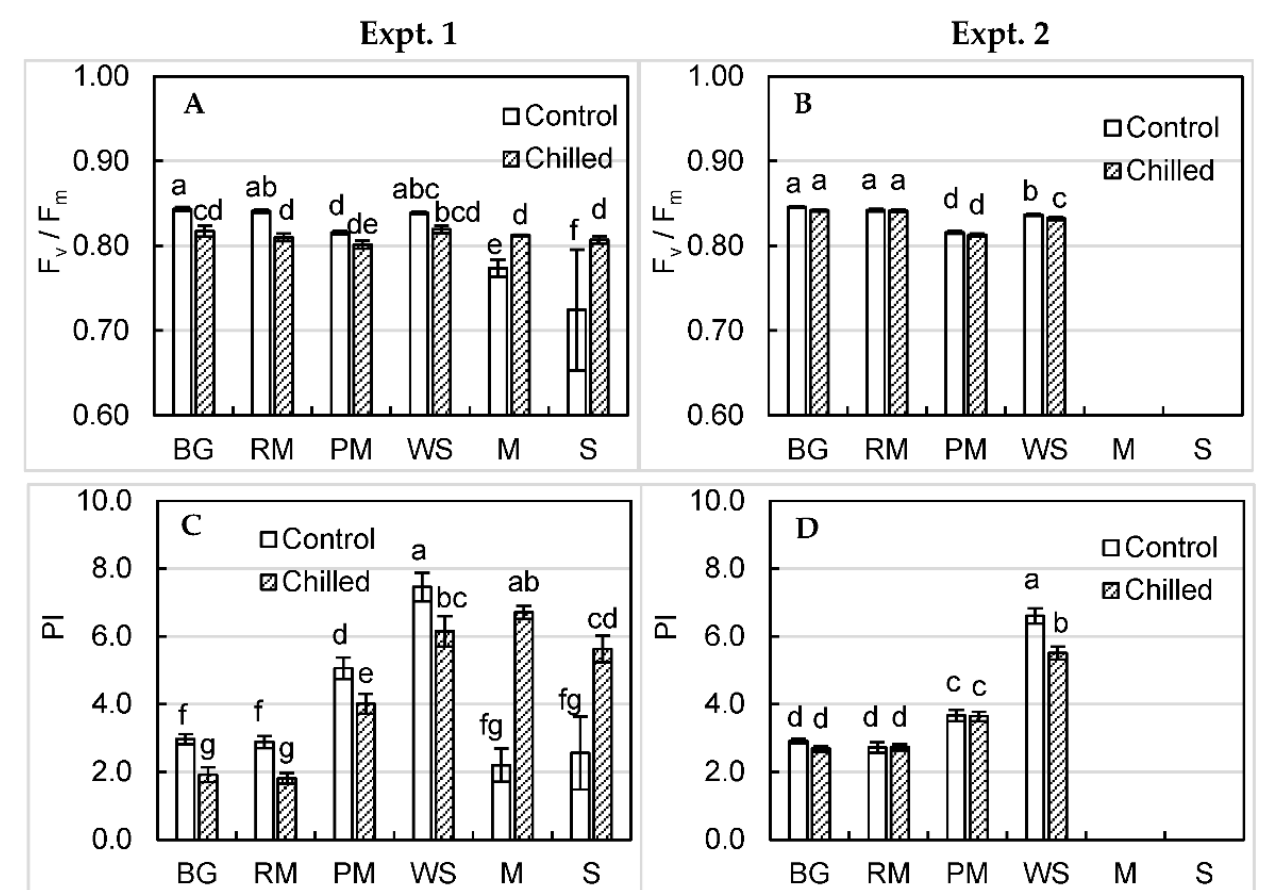
Figure 3. Chlorophyll fluorescence (F v /F m ) ( A , B ) and performance index (PI) ( C , D ) of the lettuce varieties ‘Bergam’s Green’(BG) and ‘Red Mist’ (RM), Pak Choi varieties ‘Purple Magic’ (PM) and ‘White Stem’ (WS), and spinach ( Spinacia oleracea L.) ‘Mandolin’(M) and ‘Seaside’ (S) plants grown in a deep-water culture hydroponic system with nutrient cooling or no cooling (Control). Different letters represent significant differences between treatments according to Tukey’s HSD test ( p <